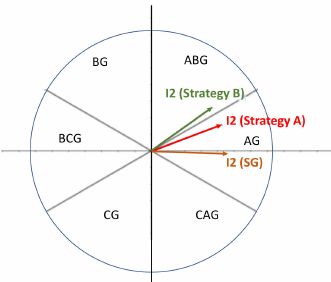
Figure 11. Graphical representation of the angle sectors used to identify single-line and double-line- to-ground faults and I2 phasor when strategy A and Strategy B with a K - factor = 2.5.